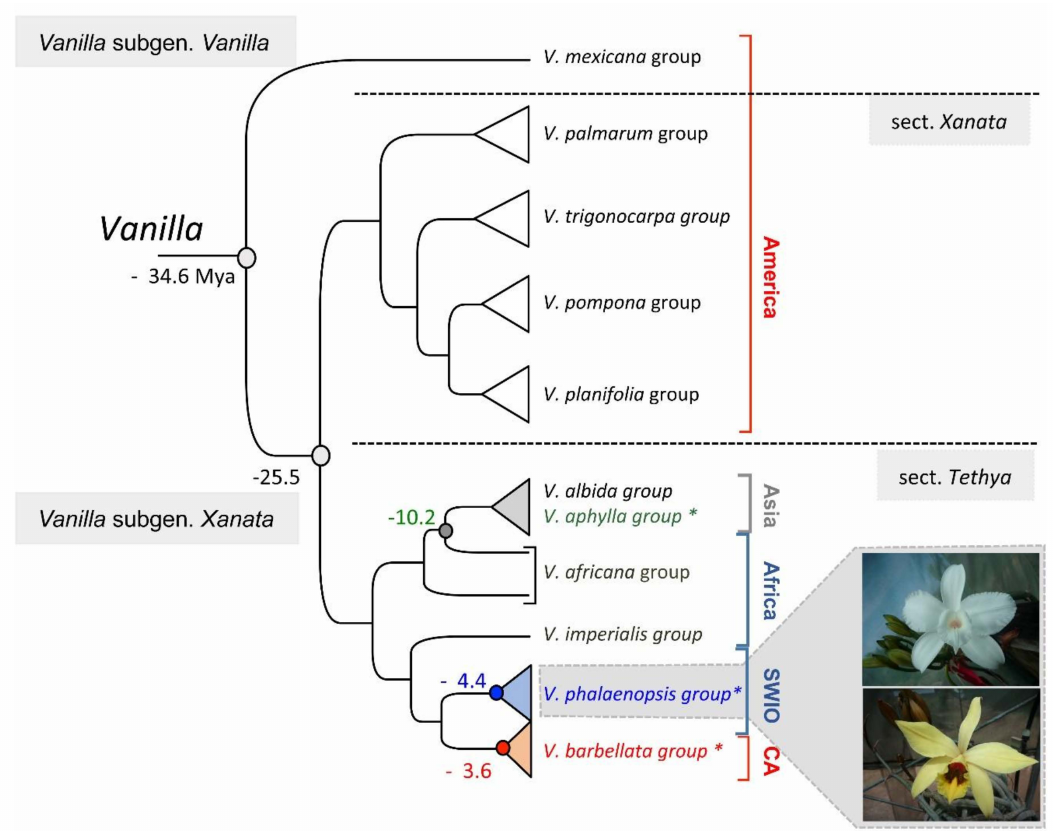
Figure 1. Representation of the (rbcL, psaB, psbB, psbC) phylogeny of Bouetard et al. in 2010 including species groups defined by Soto Arenas and Cribb in 2010, showing leafless Vanilla species names in color (green for Asia, blue for SWIO, red for Caribbean CA) [3,9]. Node dates in Mya correspond to datations obtained by Bouetard et al., with the datation of Vanilla node at − 34.6 Mya estimated using 71 Mya as the minimum age for Vanilloideae published by Ram í rez et al., 2007, based on fossil evidence of an orchid pollinarium (of Meliorchis caribea ) attached to an extinct stingless bee ( Problebeia dominica ) recovered in Miocene amber